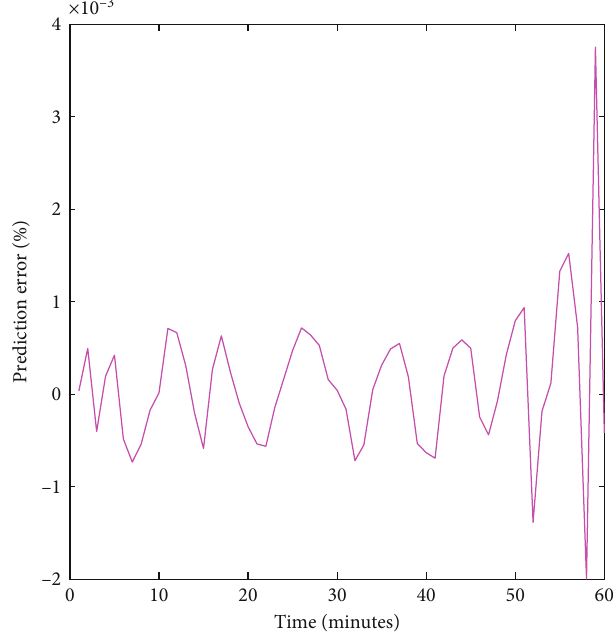
Figure 5: Prediction error vs. time for sunny day one-hour-ahead prediction.